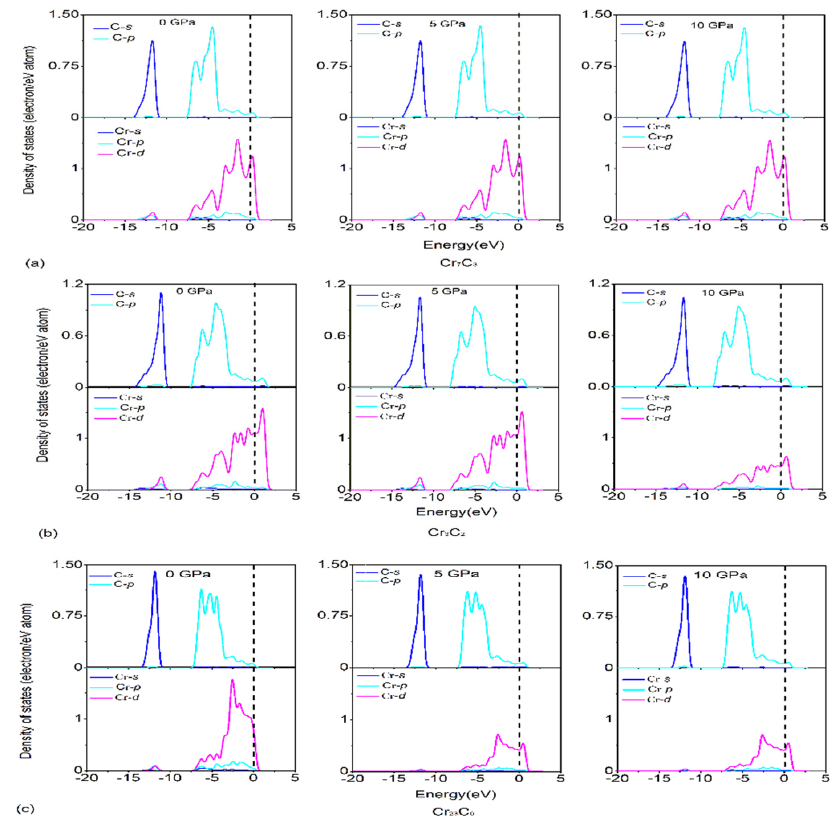
Figure 6. The partial DOS of ( a ) Cr 7 C 3 , ( b ) Cr 3 C 2 and ( c ) Cr 23 C 6 under pressure (0, 5 and 10 GPa). In order to visually demonstrate the covalent and ionic bonding characteristics, the charge density difference was measured and results are shown in Figure 7. The contour lines are plotted from − 1 to 1 e/Å 3 . It can be clearly observed that the bonding type between C and Cr is covalent, the bonding between adjacent Cr atoms is metallic, whereas the bonding around C atoms is ionic. Based on the above results, it can also be seen that binary chromium carbides have strong structural stability.